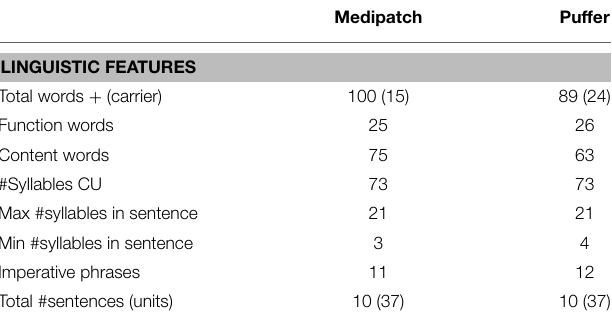
TABLE 2 | Linguistic aspects of the